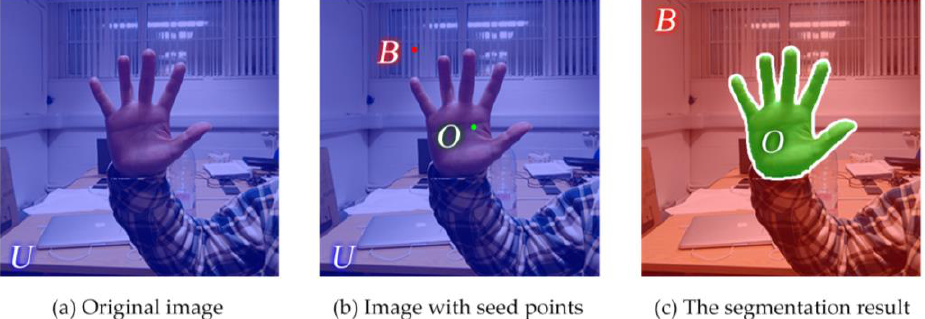
Figure 5. The relationships between three pixel sets.